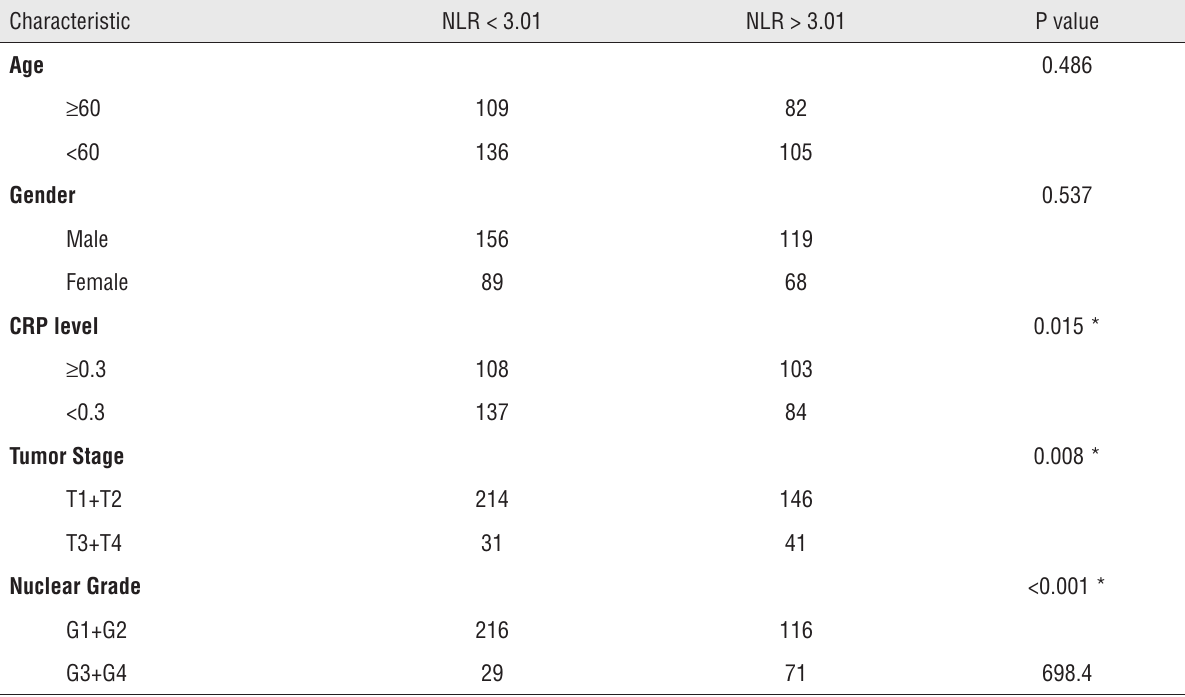
Table 2 - The neutrophil/lymphocyte ratio according to tumor parameters and markers in surgery group.